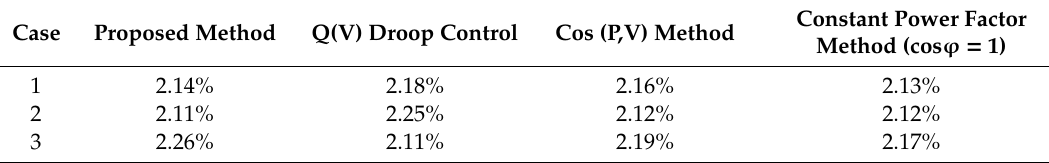
Table 8. Comparison of total harmonic distortion for each method.